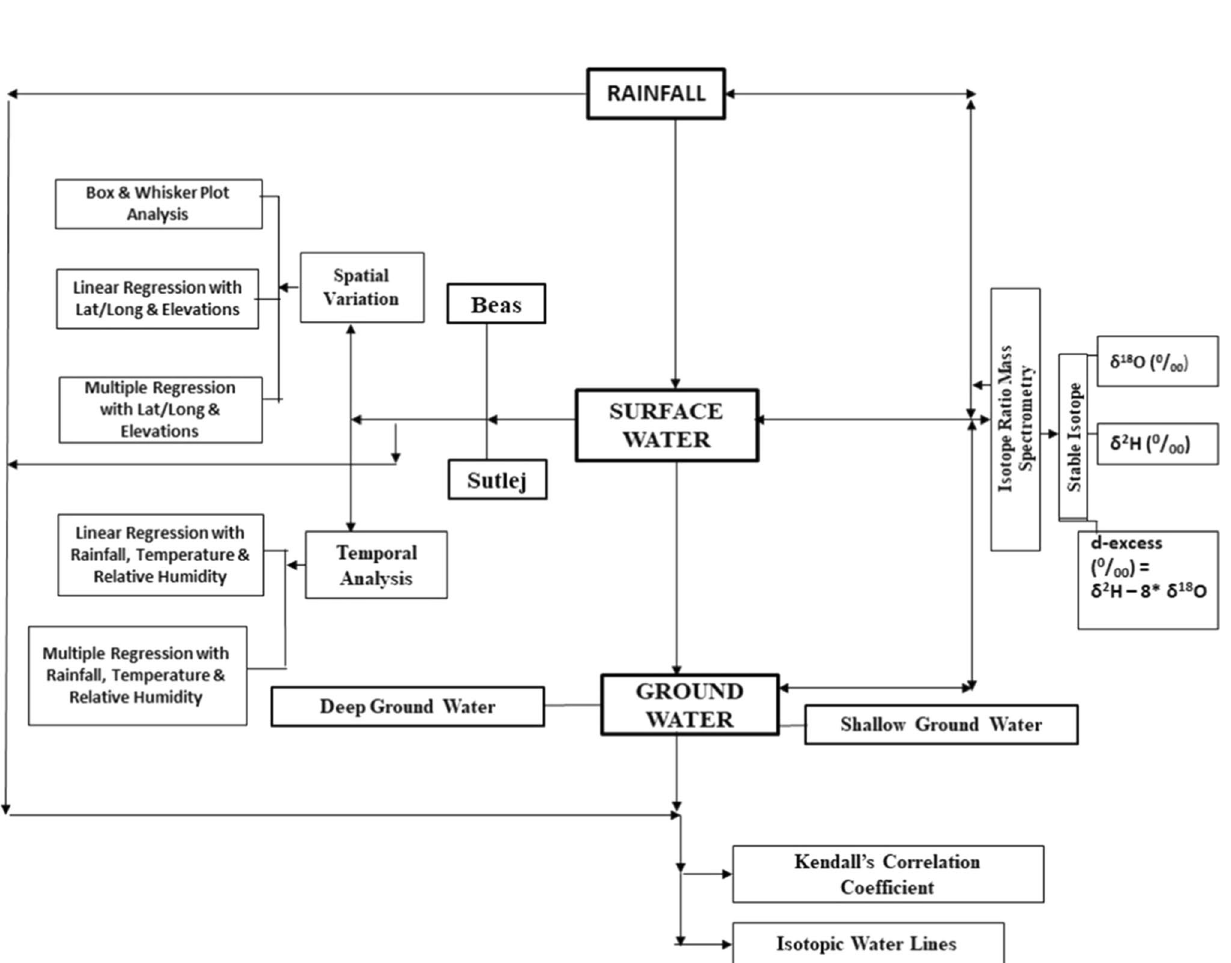
Fig. 4 Flow chart of the